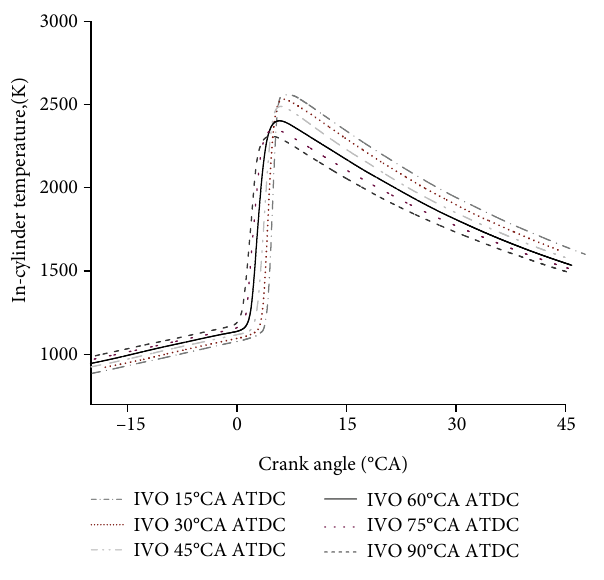
Figure 15: In fl uence of delayed IVO on temperature.